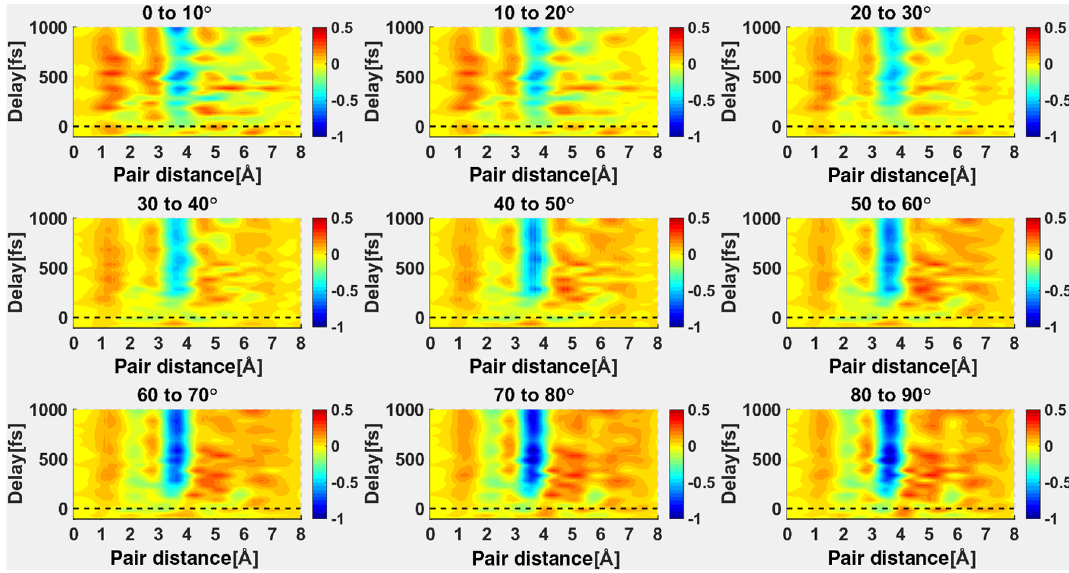
FIG. 9. Angle-dependent Δ PDF. Each panel shows the Δ PDF within a 10° polar angle region. The depletion in the I-I initial pair distance shows the largest amplitude at 90°, consistent with the fact that the transition dipole moment is strongest along the direction perpendicular to the I-I pair. Note that the angle dependence of Δ PDF is different for different atomic pair